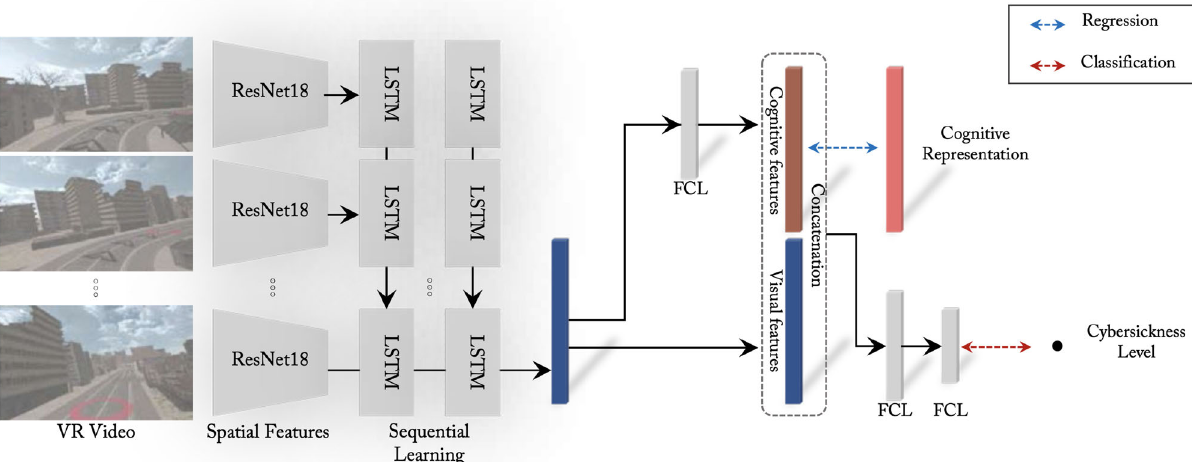
Fig. 10 Cybersickness learning predictor. Input VR video is fed into a CNN–RNN network to extract features which the fully connected layer represents as cognitive features. These are concatenated with visual features to predict cybersickness level. Reproduced with permission from Ref. [114], c (cid:2) Institute of Electrical and Electronics Engineers